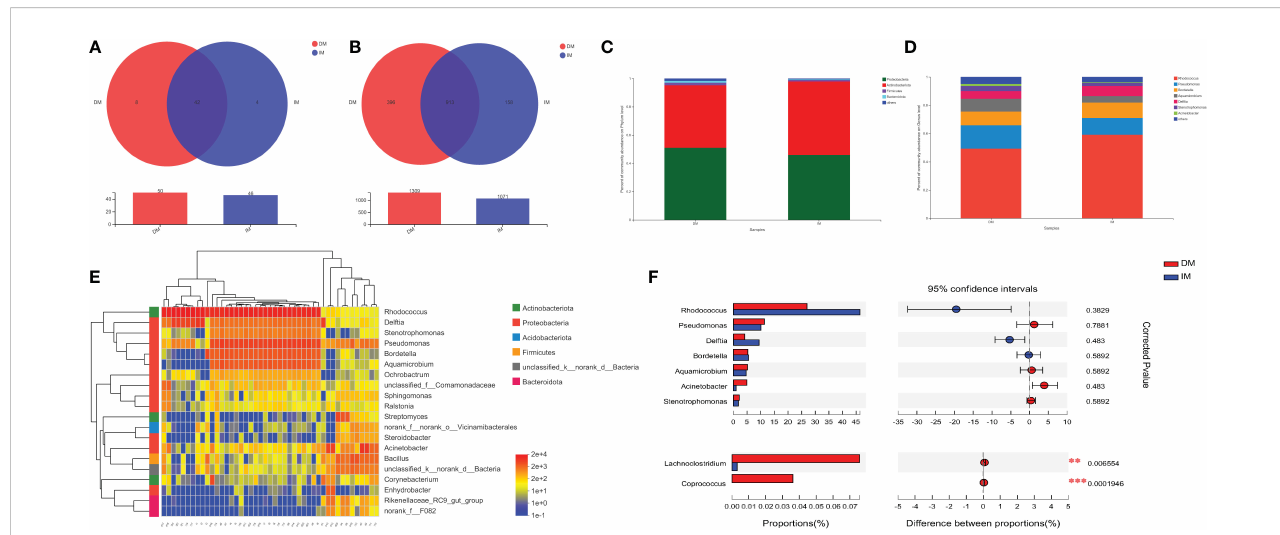
FIGURE 5 Tumor microbiome communities are signi fi cantly different between DM and IM. The Venn diagrams represent the shared and unique taxa among the different tissues by (A) the phyla cluster and (B) the genera cluster. (C) Dominant phyla of the two groups. (D) Dominant genera of the two groups. (E) Heatmap diagrams of microbial composition analysis identi fi ed top 20 genera with total abundance present across all SCRC samples. The relative abundance of species, with each represented by a different color. (F) At the genus level, the association between DM (red) and IM (blue) samples was detected by Wilcoxon signed-rank testing after correction for FDR. Selected taxa are shown with corrected p values (q). **q < 0.01; ***q <